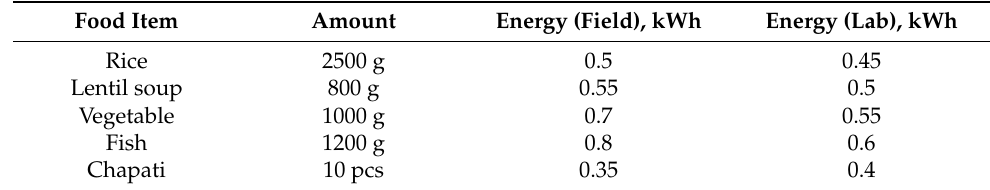
Table 4. Comparison of lab test and field test data for cooking a typical daily meal.